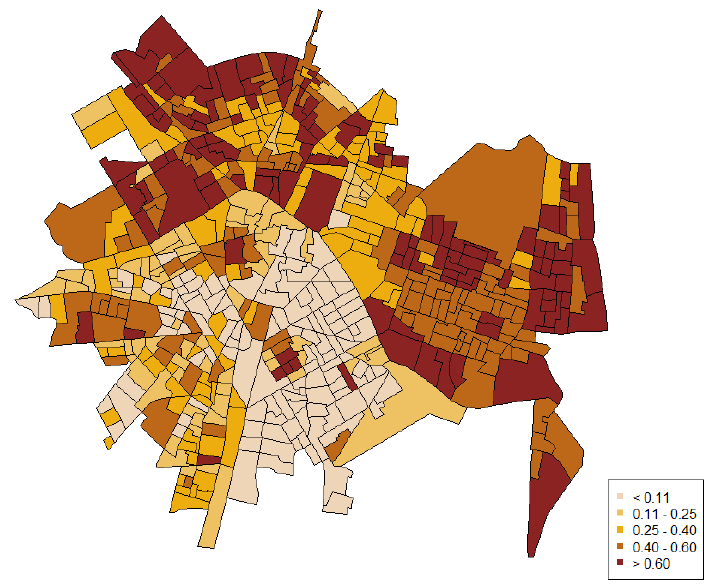
Figure 4. Posterior mean level of drug-related police interventions in each census block group.